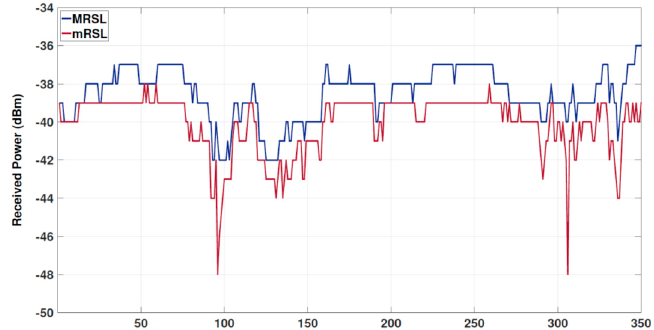
Figure 1. Typical time series of the minimum/maximum received signal level (RSL), extracted from network management system (NMS) records. The X-axis represents time at 15-min intervals.